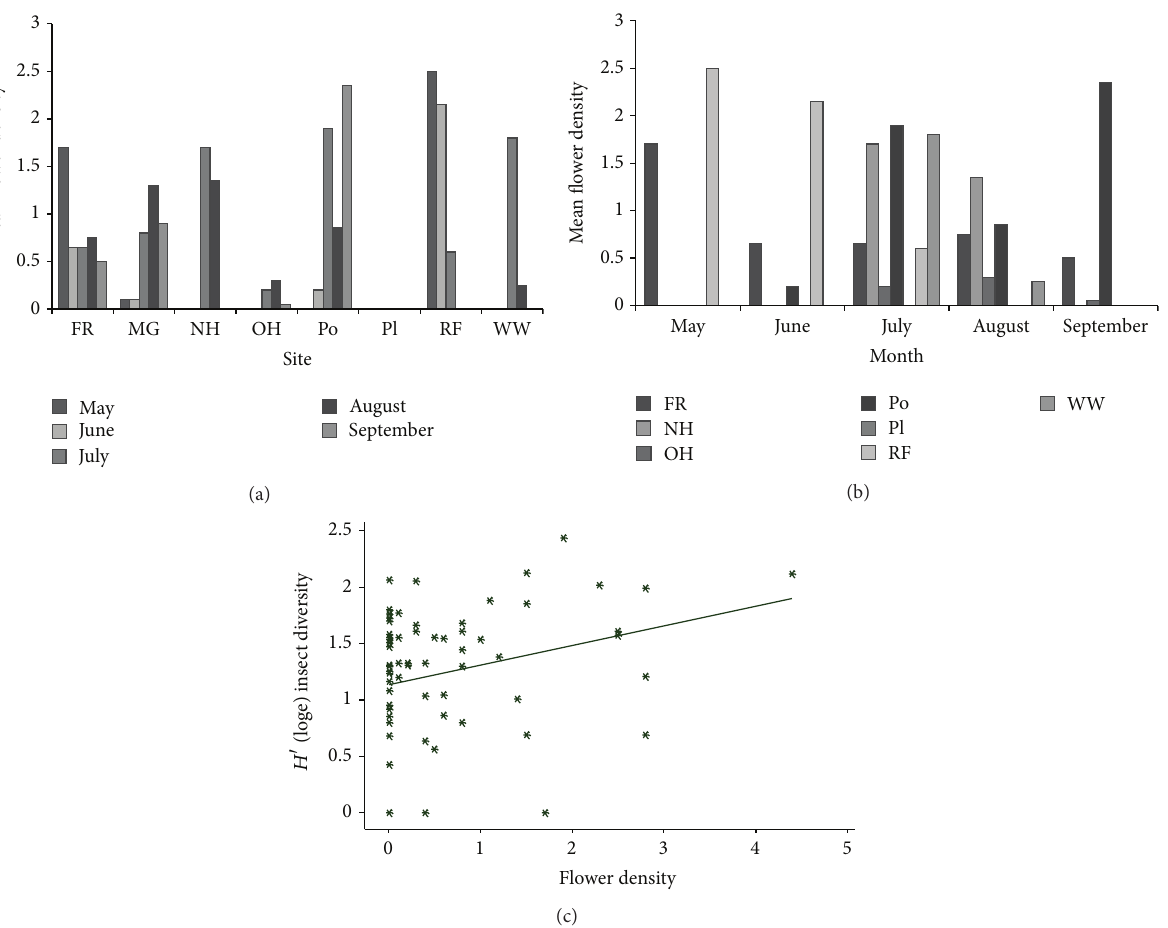
Figure 3: Floral resource across the sites: (a) mean flower density for each site subcategorised by month (b). Mean flower density for each month subcategorised by site, (c) Scatterplot with line of best fit showing the correlation between flower density and Shannon Weiner diversity score for insects. Flower rich (FR), Mown grassland (MG), New Hedge (NH), Old hedge (OH), Plantation (Pl), Pond (Po), Ridge and Furrow (RF), and Woodhorn Woodland (WW).